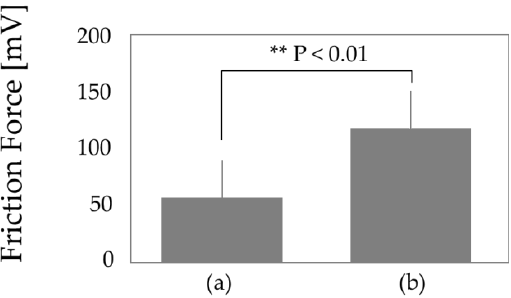
Figure 9. Friction forces of ( a ) untreated hair and ( b ) 18-MEA removed hair in wet environment (n = 5).